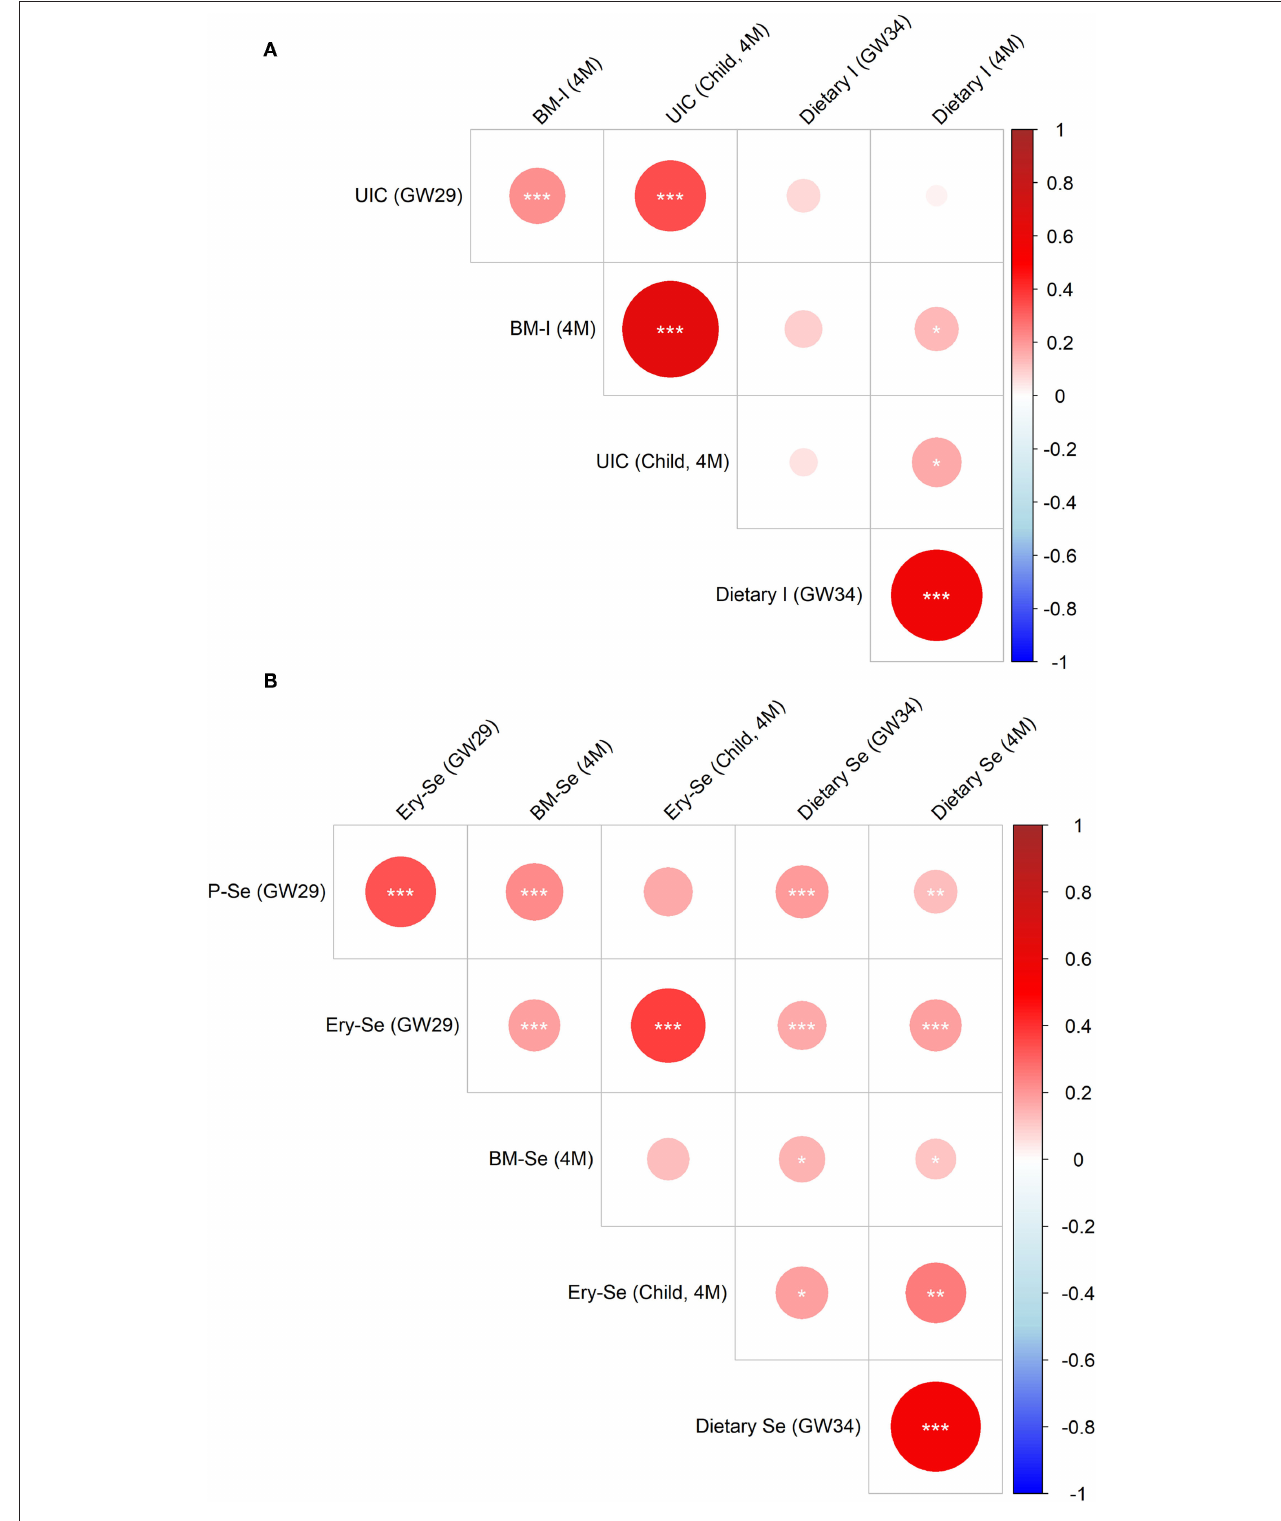
FIGURE 3 | Correlation matrix of iodine (A) and selenium (B) concentrations in erythrocytes (Ery), plasma (P), urine (U), and breast milk (BM) and estimated intake from diet in gestational week 34 (GW34) and 4 months postpartum (4M) among all included mothers and their breastfed infants. Significant correlations are denoted with asterisks as follows: p < 0.001 = *** , p < 0.01 = ** and p < 0.05 = * .